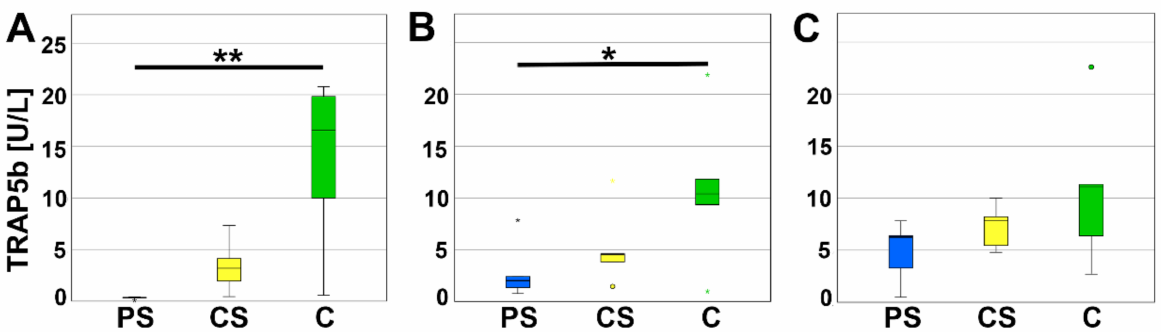
Figure 6. TRAP5b assay after 4 ( A ), 8 ( B ), and 12 days ( C ). * indicates a statistically significant likelihood of p ≤ 0.05, ** indicates a statistically significant likelihood of p ≤ 0.01. Circles and small asterisks denote